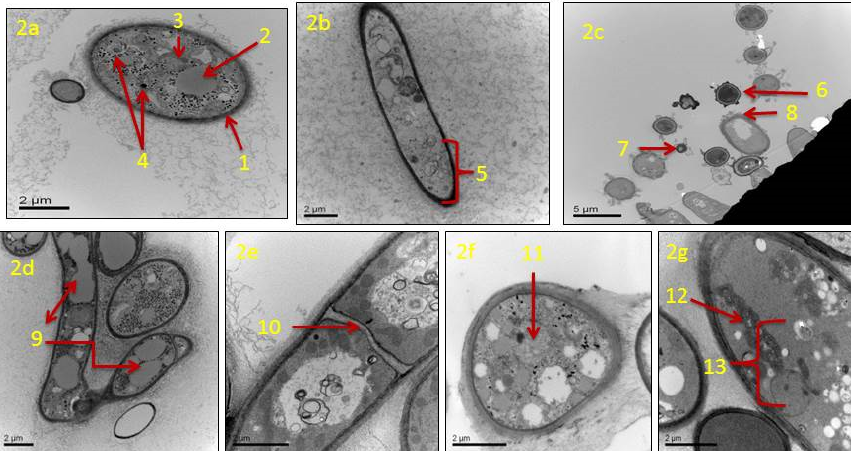
Figure 2. Transmission electron micrographs of Aspergillus flavus treated with 500 ppm of clove essential oil after seven days of incubation: ( a ) untreated healthy conidium with cell wall and cell-matrix intact; cell wall ( 1 ), vacuole ( 2 ), mitochondria ( 3 ), and nuclei ( 4 ); ( b ) untreated hypha with a clear thick cell wall and cytoplasmic matrix intact ( 5 ); ( c ) cross section of treated fungal conidia with an irregular shape ( 6 ), size ( 7 ) and disintegrated cell surface ( 8 ); ( d ) treated hyphae with extensive vacuolization in the cytoplasmic matrix ( 9 ); ( e ) treated hyphae with irregular septa ( 10 ); ( f ) treated hyphal cell with shrunken cytoplasmic contents ( 11 ); ( g ) treated hyphal cell with irregular/disrupted mitochondria ( 12 ), the absence of the nucleus and other cellular organelles ( 13 ). J. Fungi 2020 , 6 , x